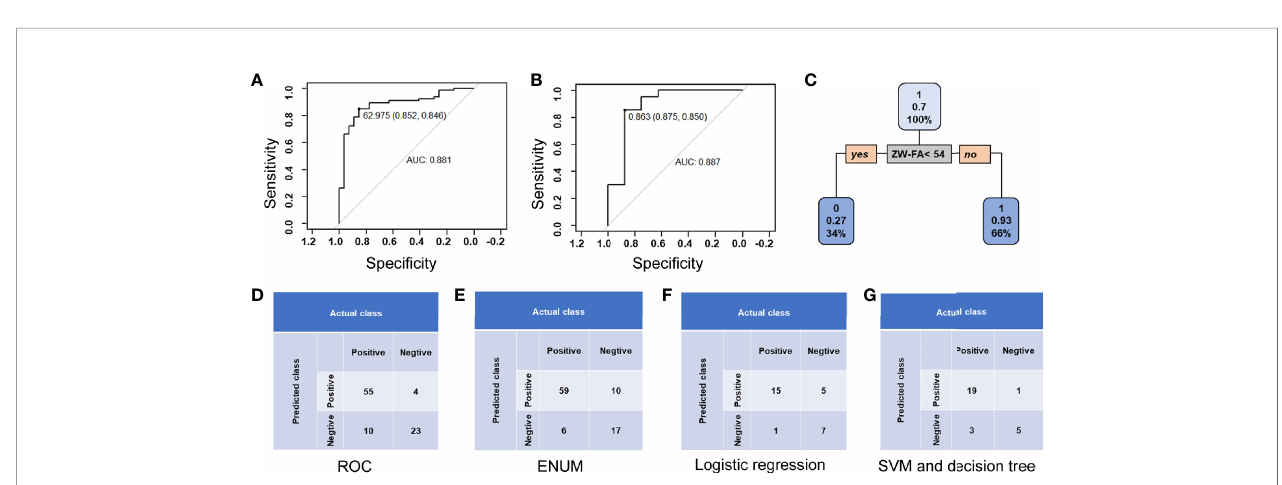
FIGURE 5 | Diagnostic utility. (A) Curve of ROC method. (B) ROC curve of logistic regression. (C) Conditional inference tree of the training set. Patients in the training set were identi fi ed as positive, de fi ned as 1, with a 0.93 accuracy. (D) Confusion matrix of the ROC method. (E) Confusion matrix of ENUM. (F) Confusion matrix of logistic regression. (G) Confusion matrix of SVM and decision